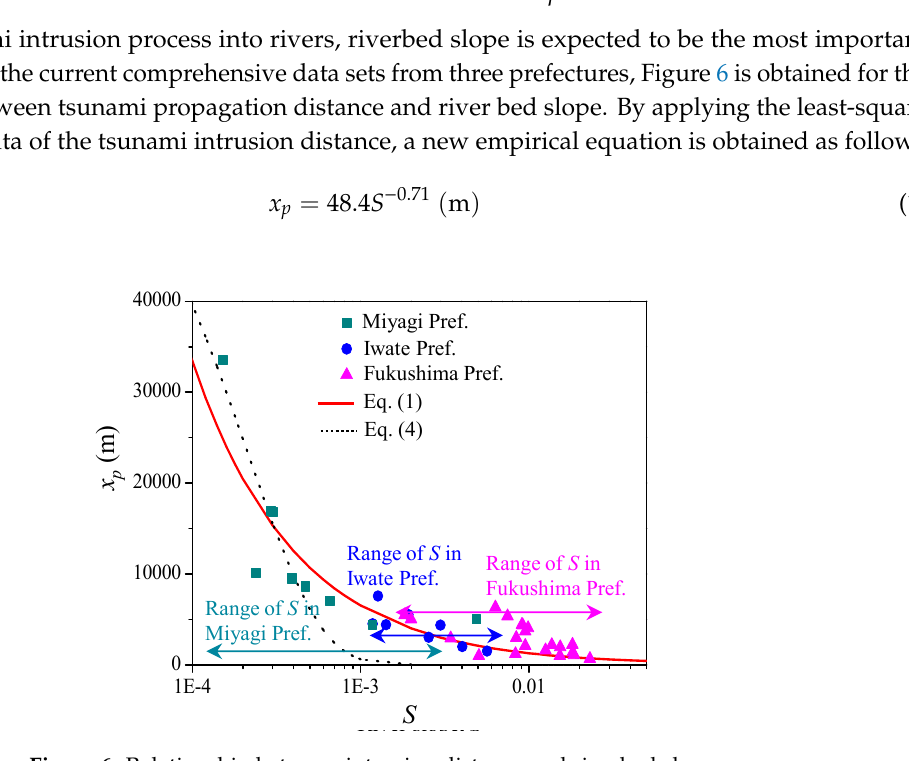
Figure 6. Relationship between intrusion distance and riverbed slope.